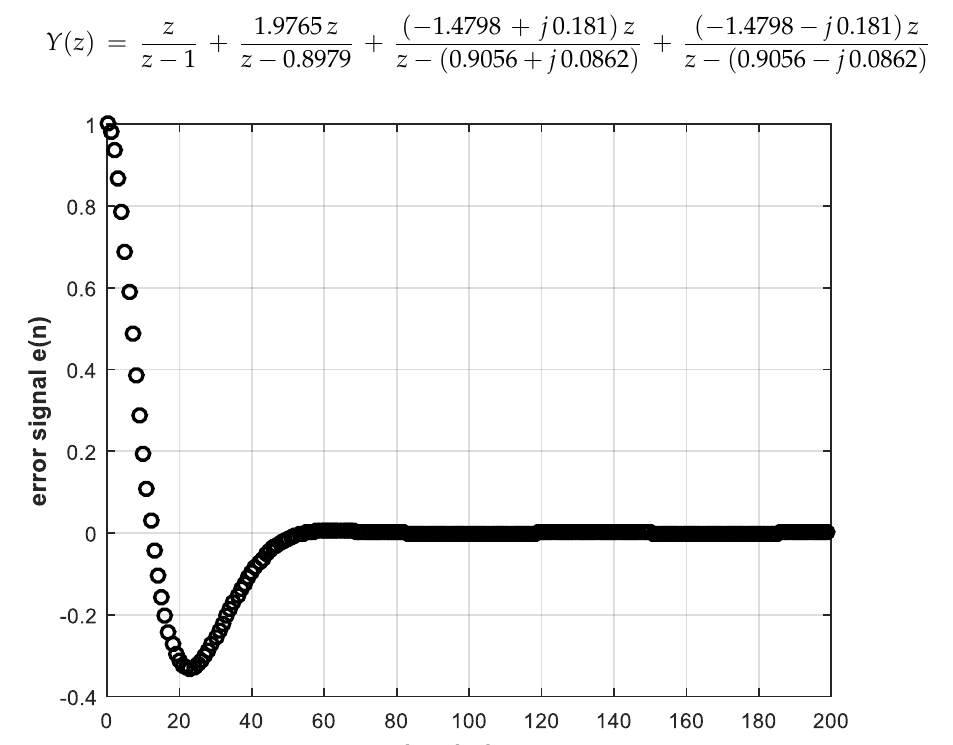
Figure 4. The control signal output from the digital controller.